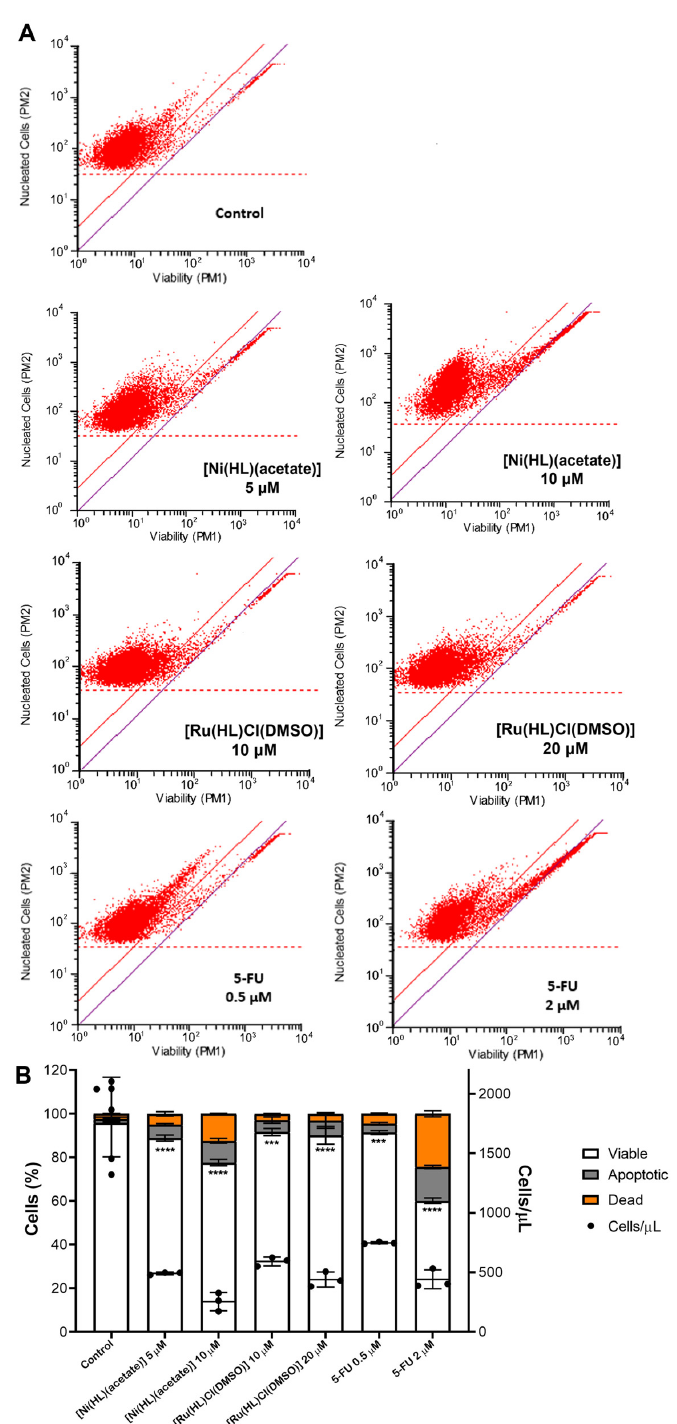
Figure 9. Evaluation of [Ni(HL)(acetate)], [Ru(HL)Cl(DMSO)] and 5-FU effect on CT-26 cell viability by Guava ViaCount. ( A ) Cell populations obtained by Guava ViaCount flow cytometry analysis after 48 h incubation with different concentrations of each compound. ( B ) Percentage of viable, apoptotic and dead cells, as well as number of cells/ μ L. Data are expressed as mean ± SD of two independent experiments. *** p < 0.001, **** p < 0.0001 vs. control. Statistical analysis was performed by two-way ANOVA with Dunnett’s test.